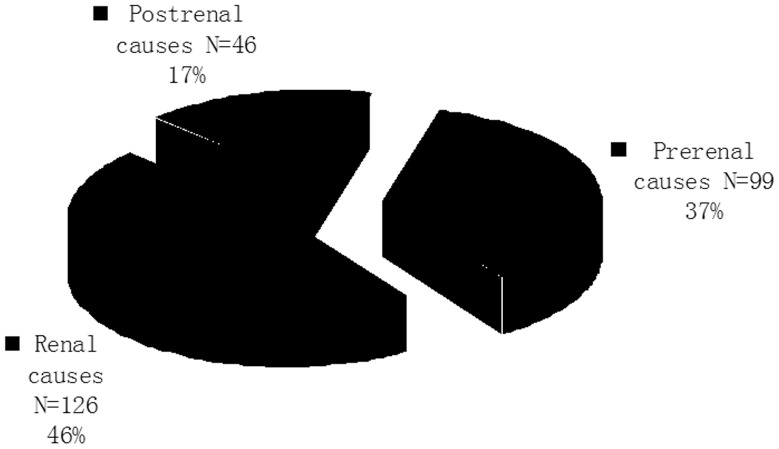
Etiologies of AKI patients.Causes of AKI were categorized into prerenal, renal, and postrental.